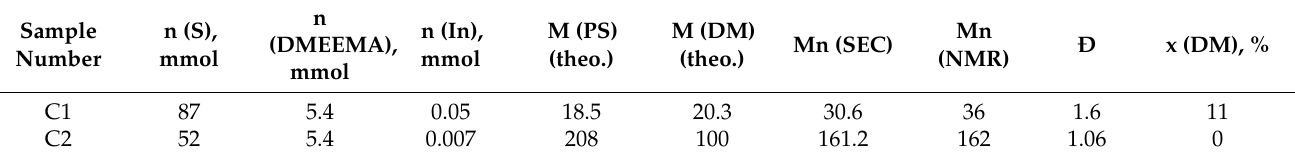
Table 3. Results of the synthesis of PS-b- PDMEEMA by combined SAP-ATRP mechanism.